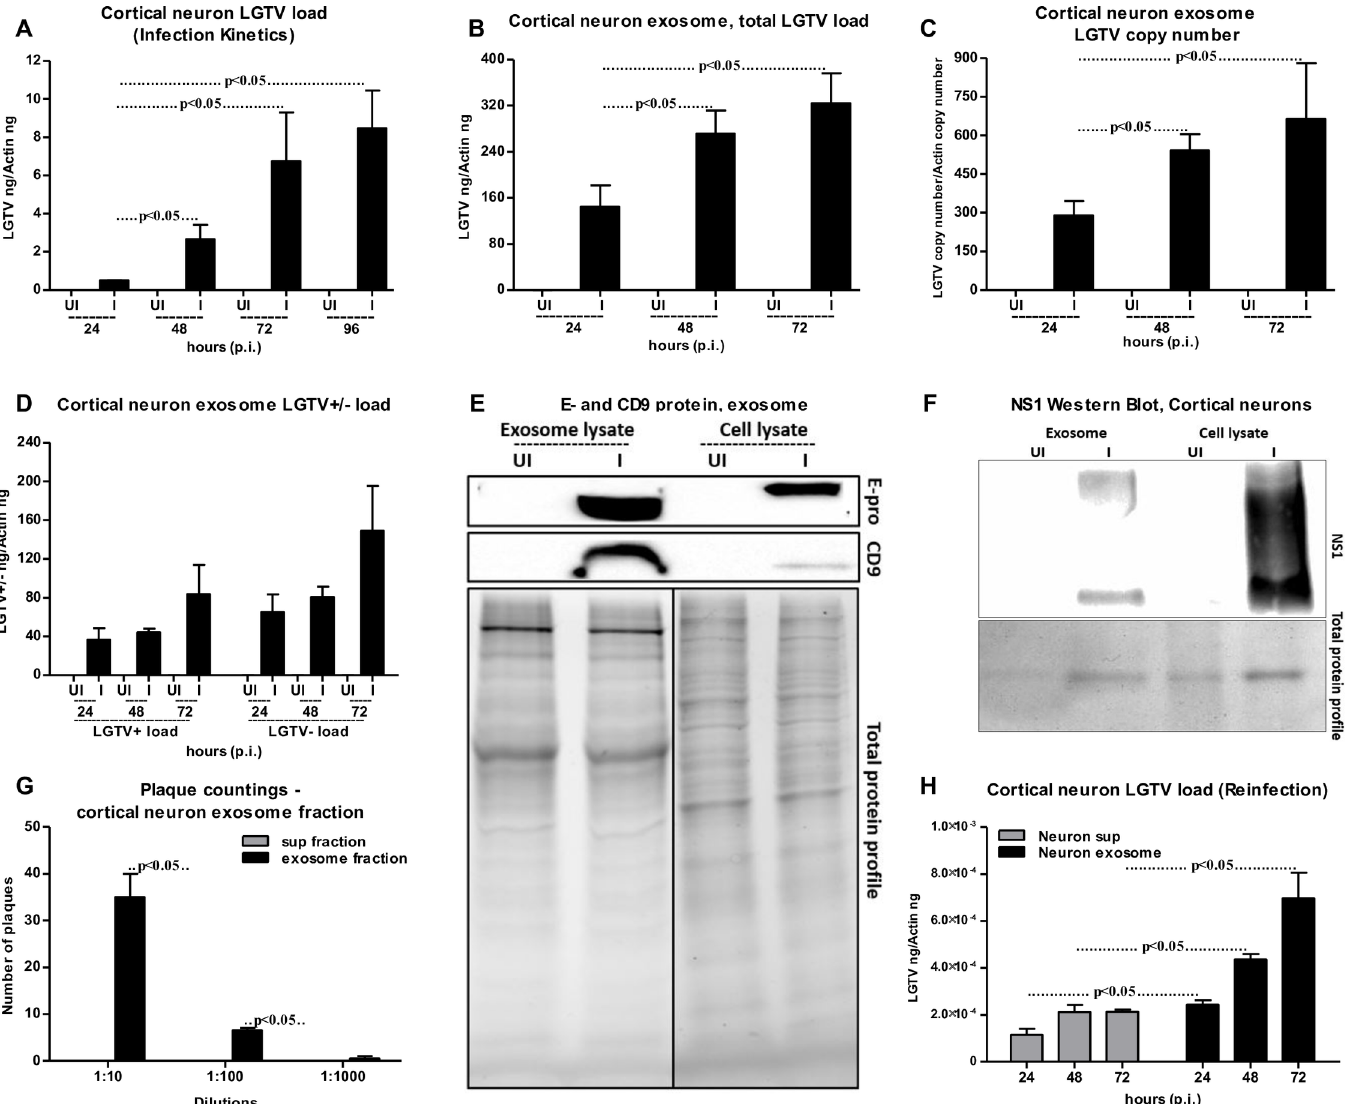
Fig 6. Detection of LGTV RNA and proteins in exosomes isolated from primary cultures of mouse cortical neurons. LGTV (4 MOI) was used to infect 1 x 10 5 murine cortical neuronalcells. UI indicatesuninfectedand I indicatesLGTV-infected. (A) QRT-PCR analysisshowingLGTV infectionkinetics in primary cultures of mouse cortical neuronsat different time points (24, 48, 72, 96 h p.i.). Total LGTV loads in exosomes isolatedfrom cortical neurons(B), copy numbers(C) and levels of LGTV positive-sense strand or negative-sense strand (D) in exosomes isolatedfrom cortical neuronalcells at different time points (24, 48 and 72 h p.i.). (E) Immunoblottinganalysisshowingdetectionof LGTV E-proteinand mammalianexosomal marker CD9 in exosome fraction and total lysates from wholecells preparedfrom uninfected(UI) or infected (I) cortical neuronalcells at 48 h p.i. Stain-free gel showingtotal protein profile serves as the loadingcontrol. (F) Immunoblotting analysisshowingNS1 levels in total neuronallysates and exosomes derived from LGTV-infected (MOI 4; 72 h p.i.) cortical neurons. Uninfected (UI) cells and exosomes derivedfrom these cells serve as controls in additionto total protein profiles. For immunoblotting assays, 2 x 10 7 cortical neuronalcells were infected with 4 MOI of LGTV. (G) Quantitative assessment of number of plaquesfrom exosomal and supernatant fractions is shown. (H) QRT-PCR analysisof viral loads in 1x 10 5 na ï vecortical neuronalcells at 24 h p.i., infected through treatment with exosomes(20 μ l) or supernatant fractions (400 μ l) preparedfrom 24, 48 and 72 h p.i., LGTV-infected neuronsshow presenceof LGTV. LGTV transcript levels were normalized to mouse beta-actin. P value determined by Student’stwo-tailed t test is shown. Representative data is shown from at least three